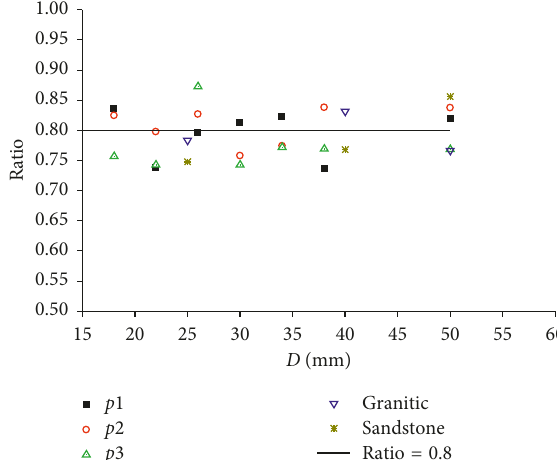
Figure 15: Ratio of the failure load against distance D with various forms of numerical models and laboratory